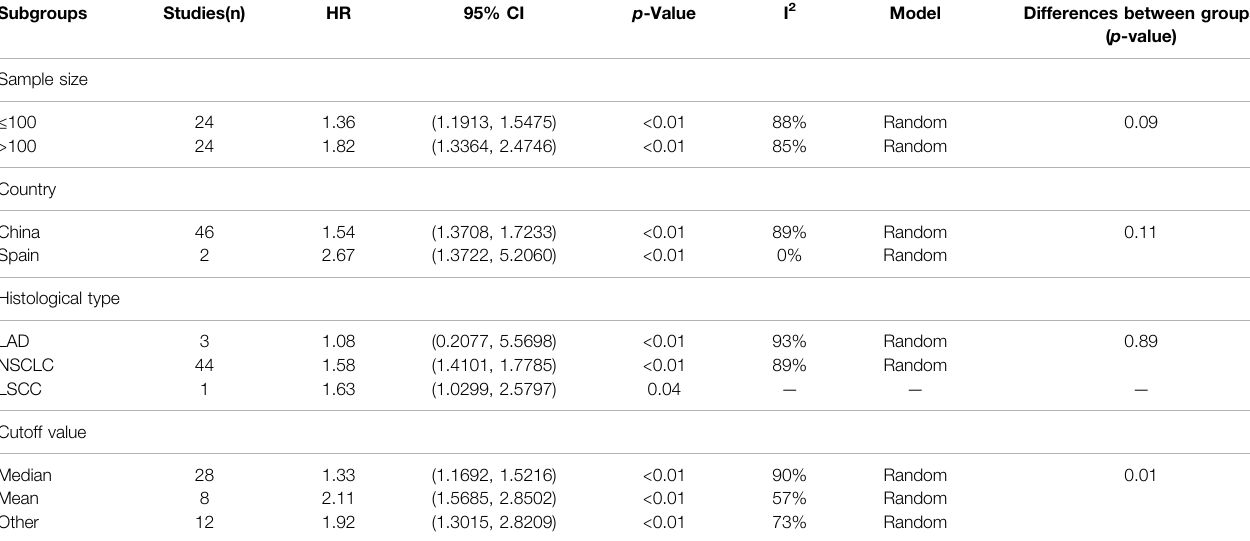
TABLE 3 | Subgroup meta-analysis of pooled hazard ratio (HR) for overall survival.